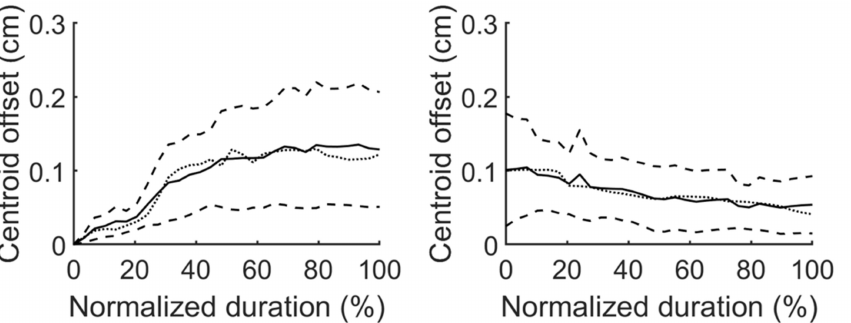
Figure 6. Temporal profiles of the morphological characteristics of MNs labelled manually during fingers flexion and extension, including the CSA and the perimeter of the nerve, the MN circularity, and the centroid displacement throughout the motion. The phase duration was rescaled by normal- ization. The data were pooled from the data of duration confined by the D 90 defined in Figure 3. In the individual panel, the solid line represents the average of the resampled data, the dash lines stand for average plus and minus one standard deviation, and the dotted line refers to the average calculated from the inference data,